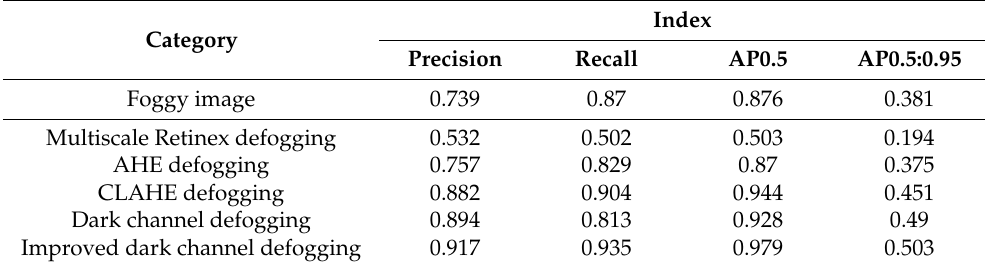
Table 4. Comparison of detection results with different defogging algorithms for multiple